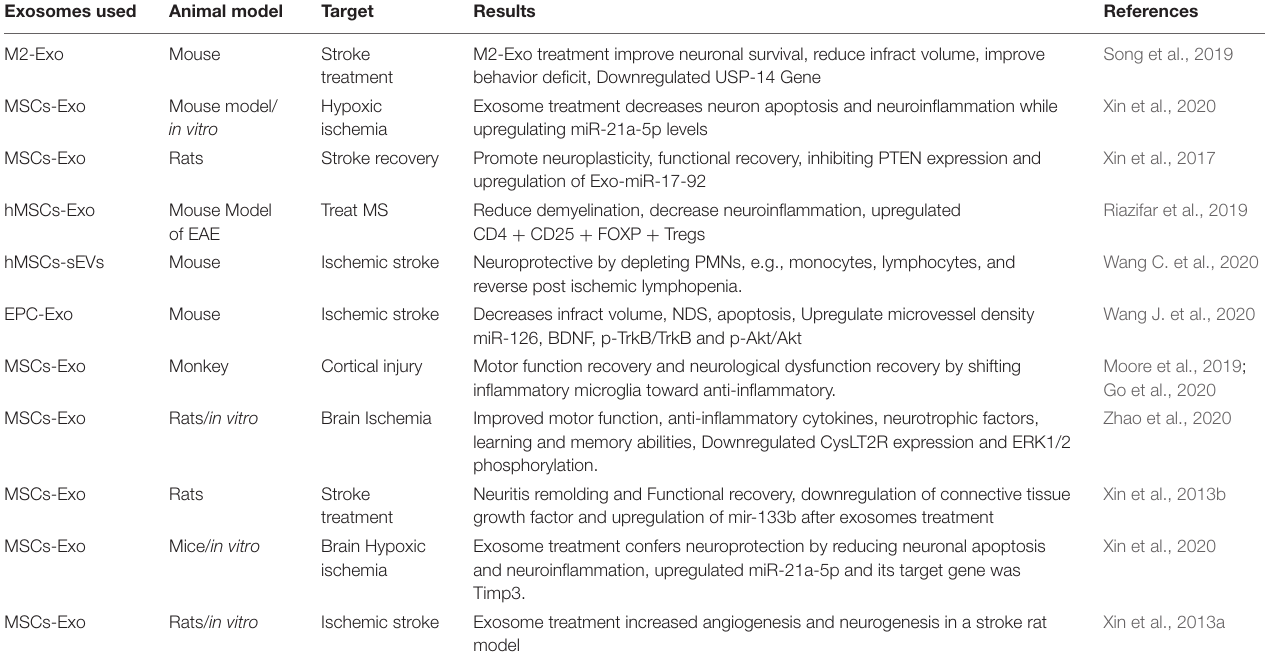
TABLE 1 | Native exosomes for ischemic